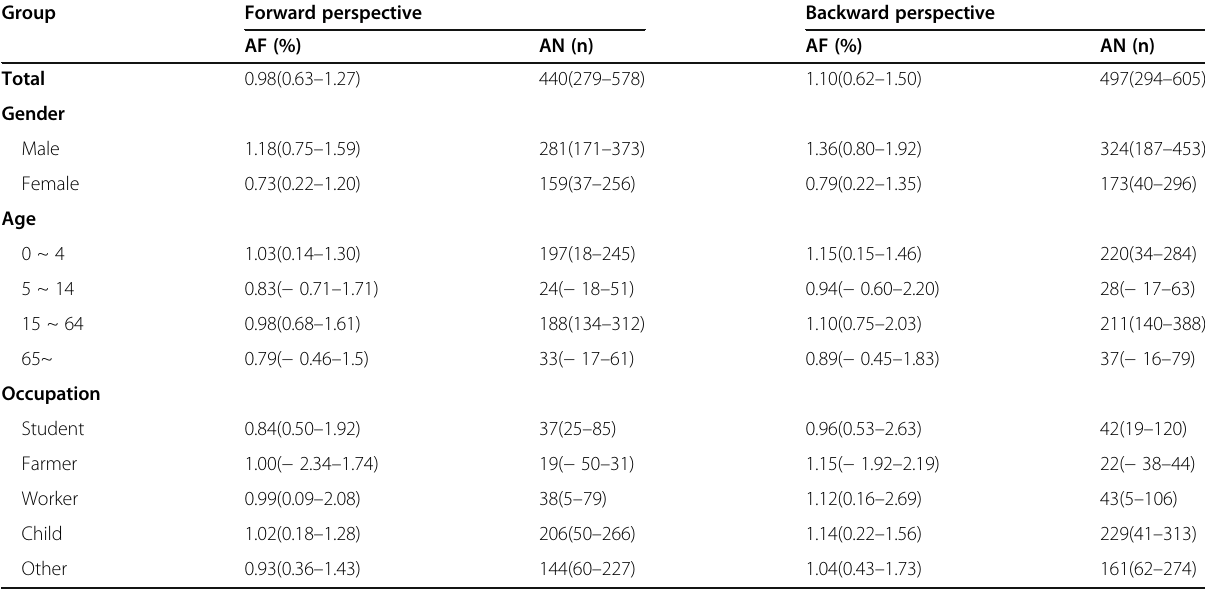
Table 4 Attributable fraction and number of bacillary dysentery incidence to floods between 2005 and 2016